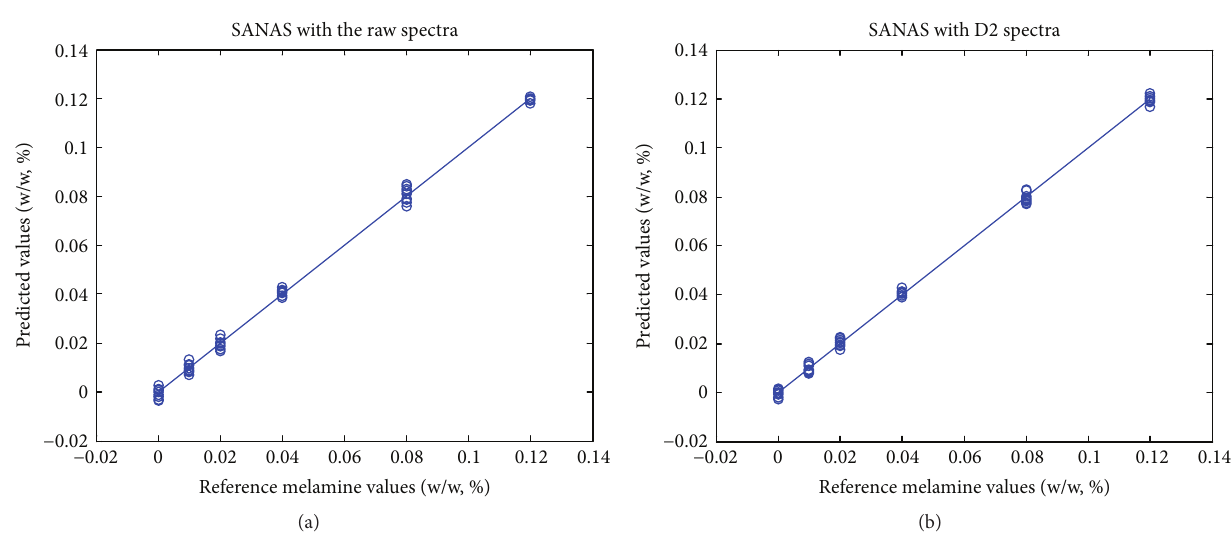
Figure 4: The NAS vectors of milk powder sample Q1.